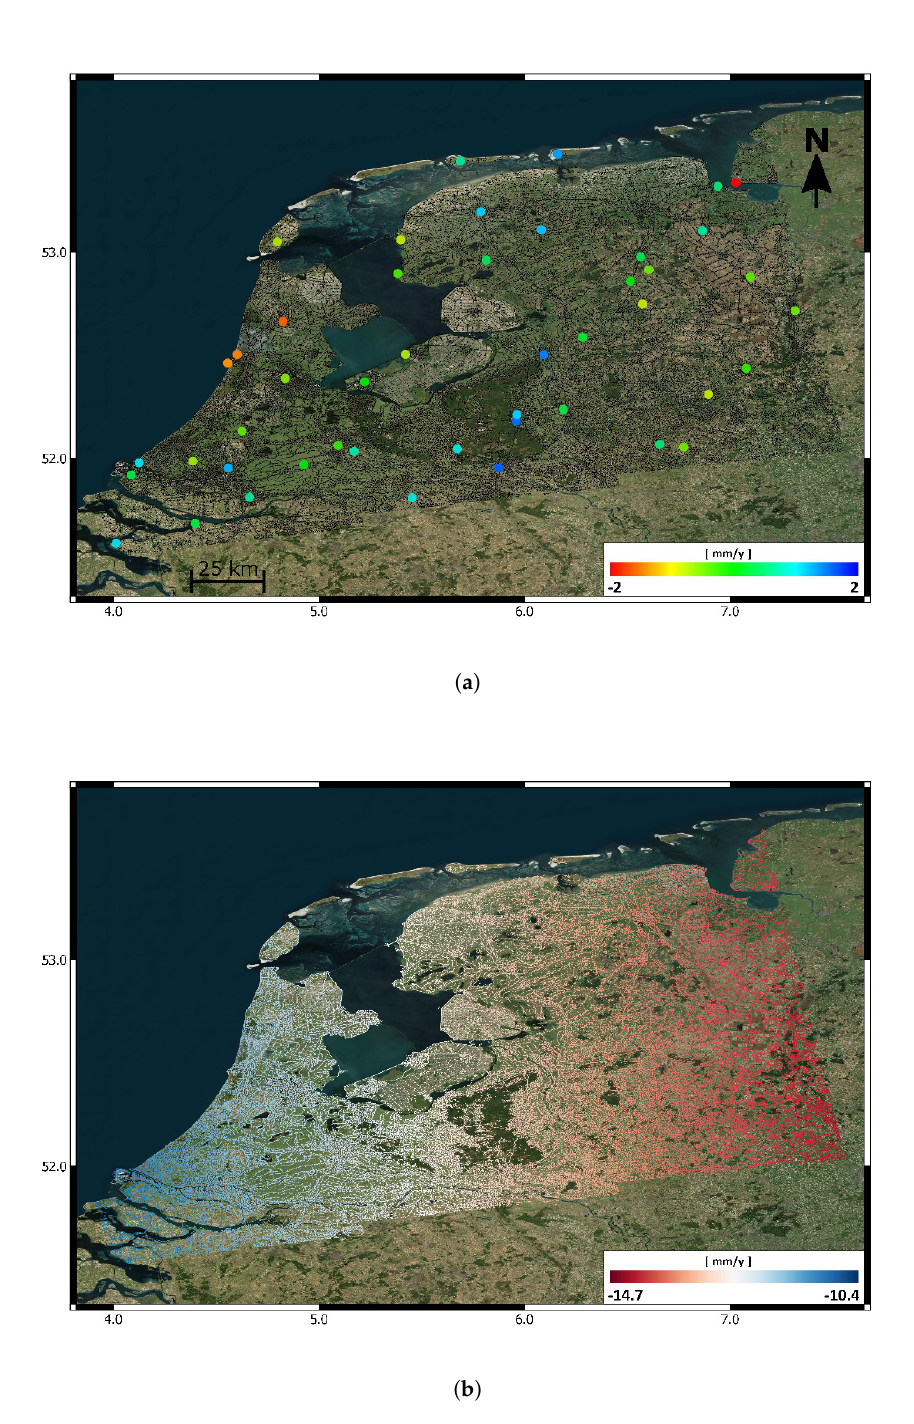
Figure 7. Results for the ascending Holland stack, showing the measured and color-coded ∆ 0 in ( a ) and the removed continental drift screen in ( b